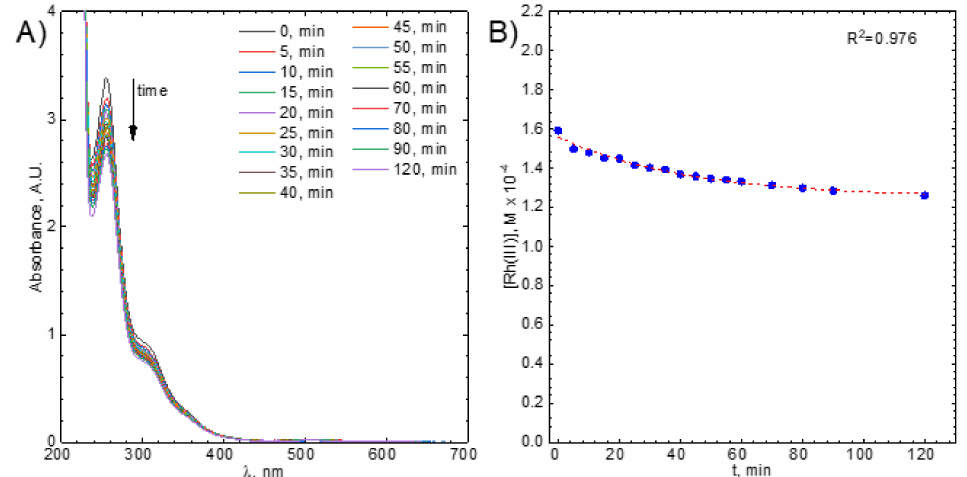
Figure 9. ( A ) UV-Vis spectra evolution during the adsorption process, ( B ) kinetic curve registered and fitted kinetic model. Experimental conditions: V = 1200 rpm, [C] = 0.5 g, [Rh(III)] 0 ~1.1 × 10 − 4 M, pH = 1, [Br] − = 0.6 M T = 50 ◦